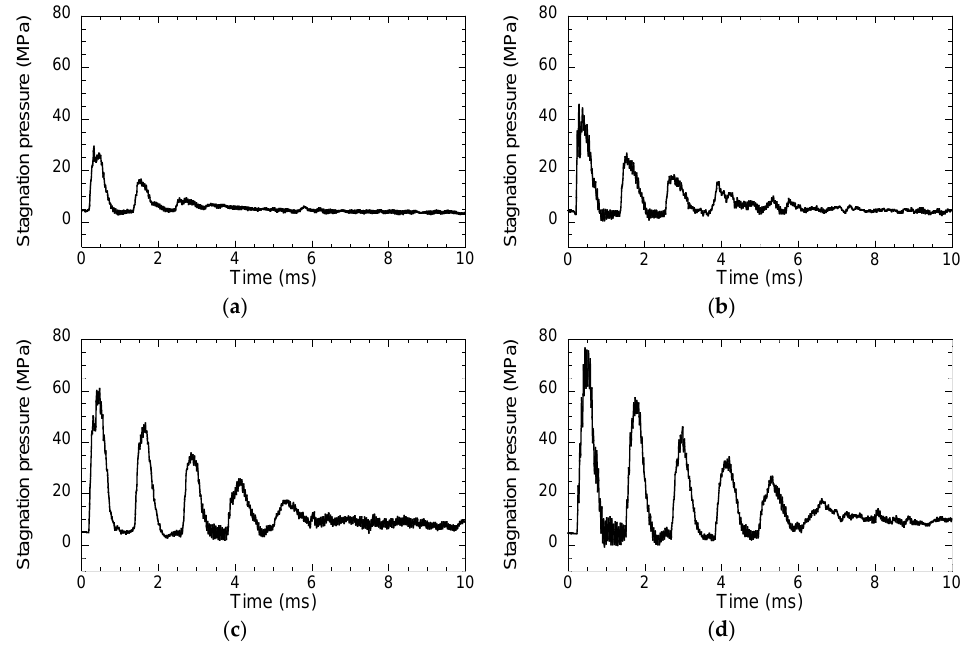
Figure 4. Sample pressure traces from the experiment with combustible initial pressures of ( a ) 25 kPa; ( b ) 30 kPa; ( c ) 40 kPa and ( d ) 50 kPa.